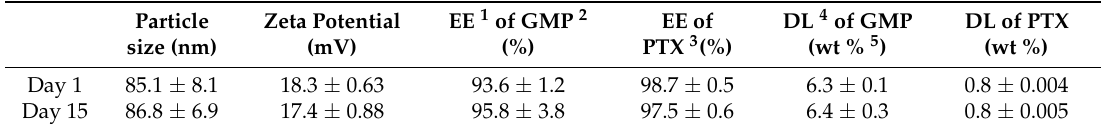
Table 1. Stability of P/G-NPs over 15 days.